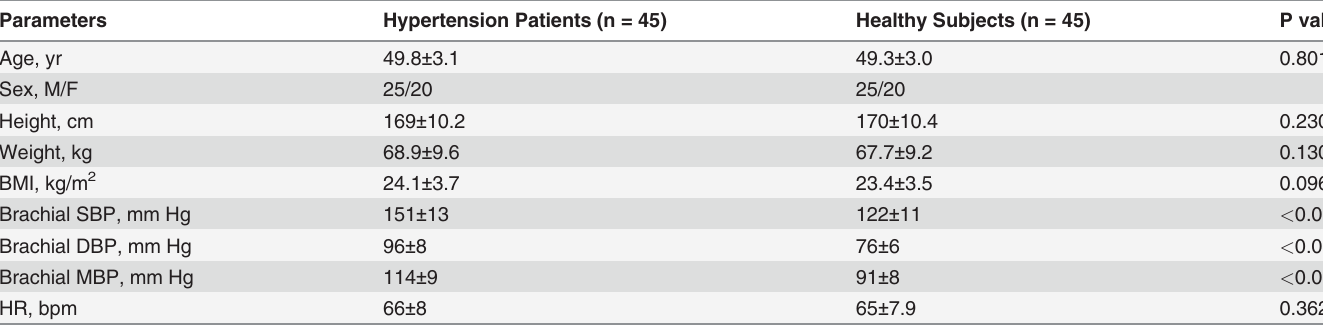
Table 3. The common characteristics of the participants in the in vivo study.